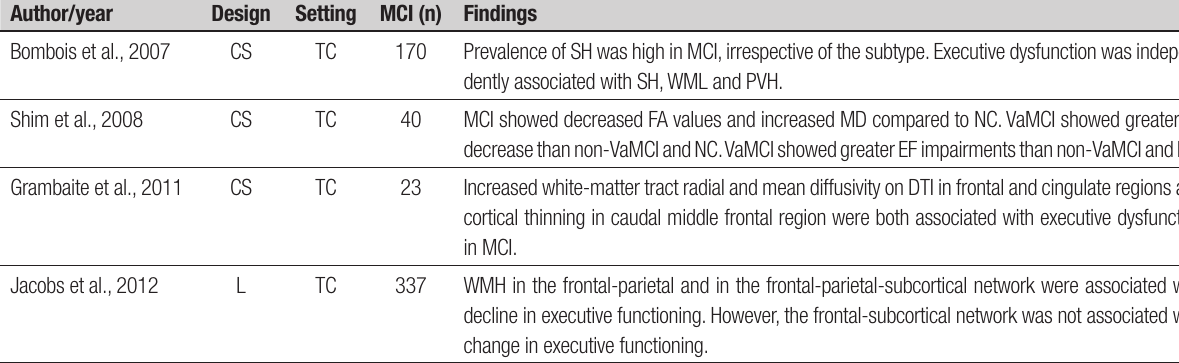
Table 2. Characteristics of studies on neuroimaging aspects of non-amnestic VaMCI included in this